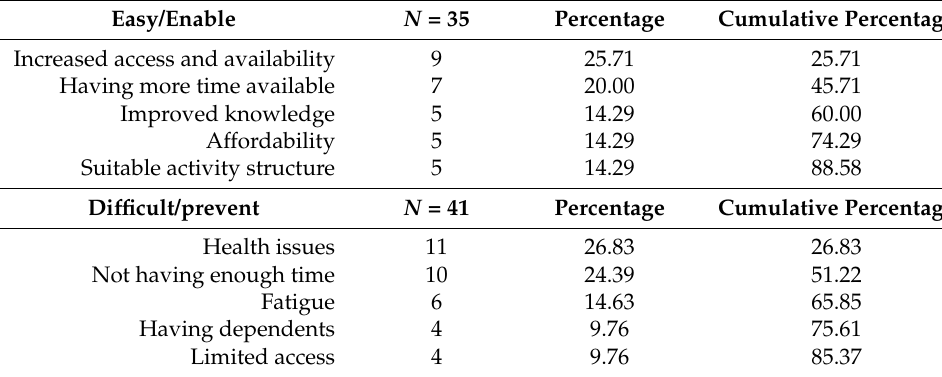
Table 4. Modal salient control beliefs of pregnant women in East